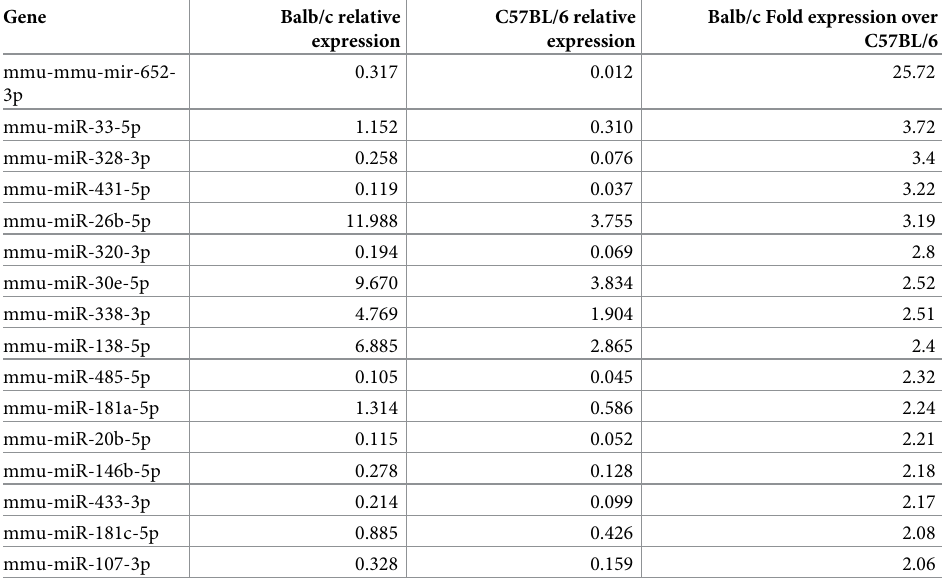
Table 1. List of genes with more than 2-fold difference in expression levels in Balb/c and C57BL/6 mice.